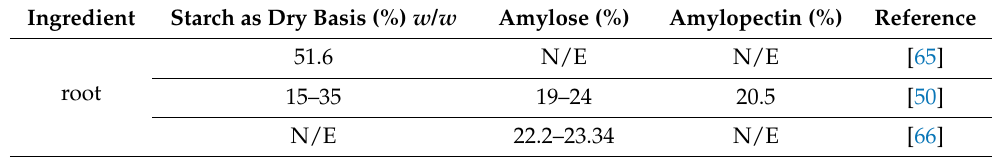
Table 3. Composition of kuzu starch isolated from its